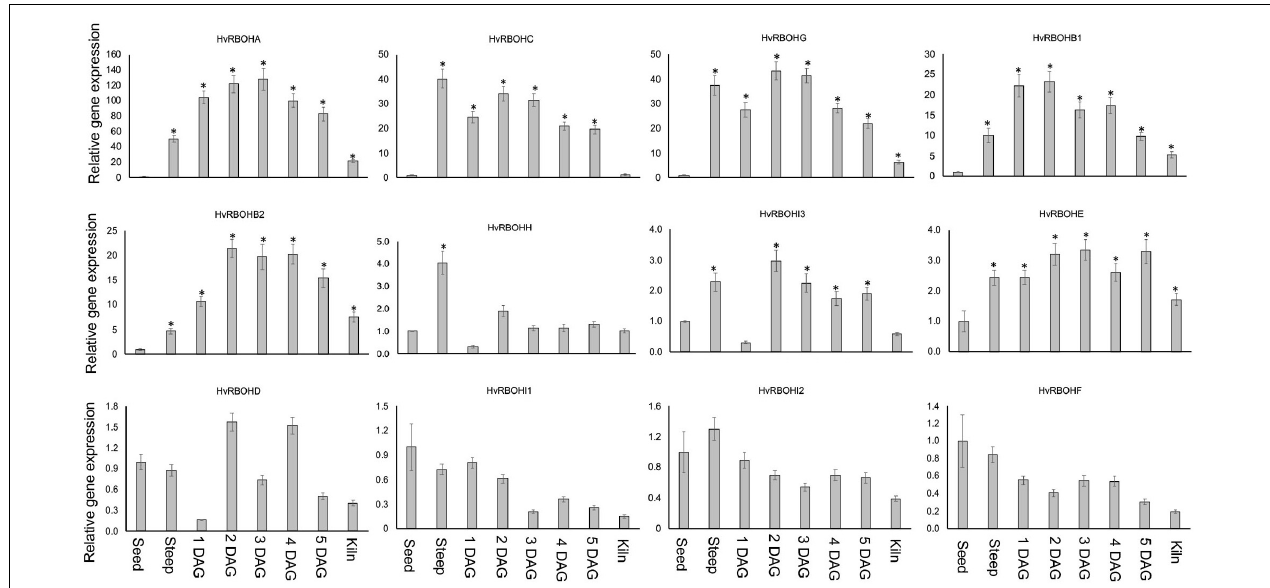
FIGURE 6 | Expression of the HvRBOH genes during different stages of malting in variety Conrad. Relative expression of each gene in various malting stages was with reference to their expression in dry seeds. Error bars represent standard error of the average cT values ( n = 4). ∗ Represent significantly different changes ( > log 2 -fold) in the HvRBOH expression when compared to their expression levels in the dry seeds ( p < 0.05). HSP70 was used for normalization.